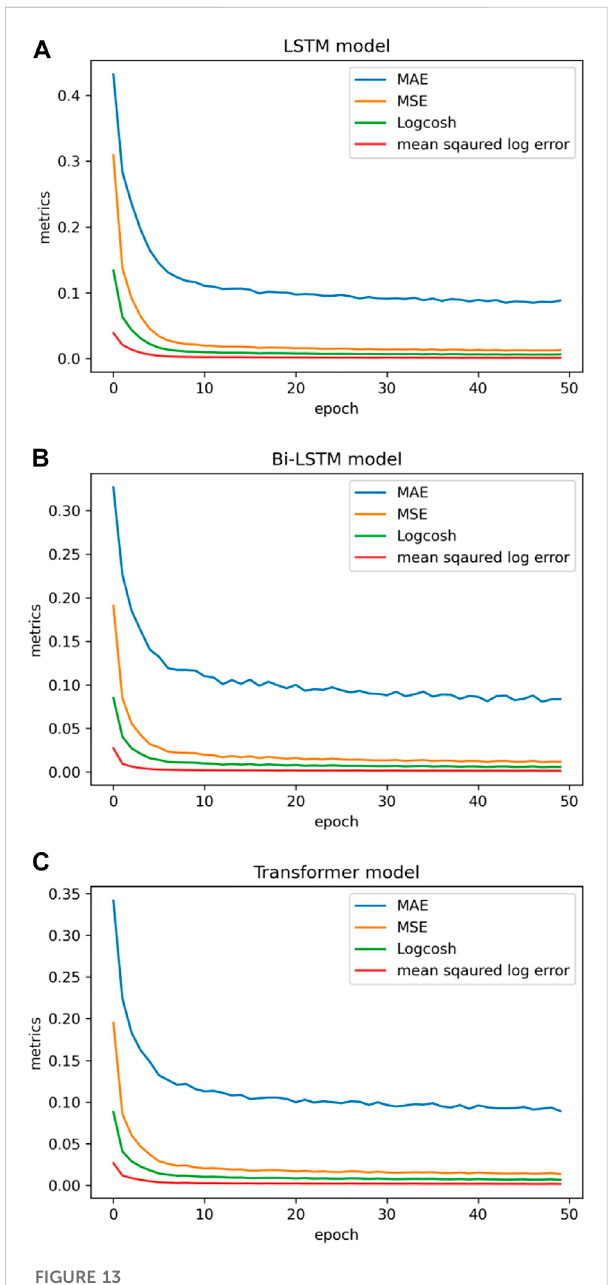
FIGURE 13 Performance metrics using (A) LSTM, (B) Bi-LSTM, and (C) transformer model on the Indonesia earthquake